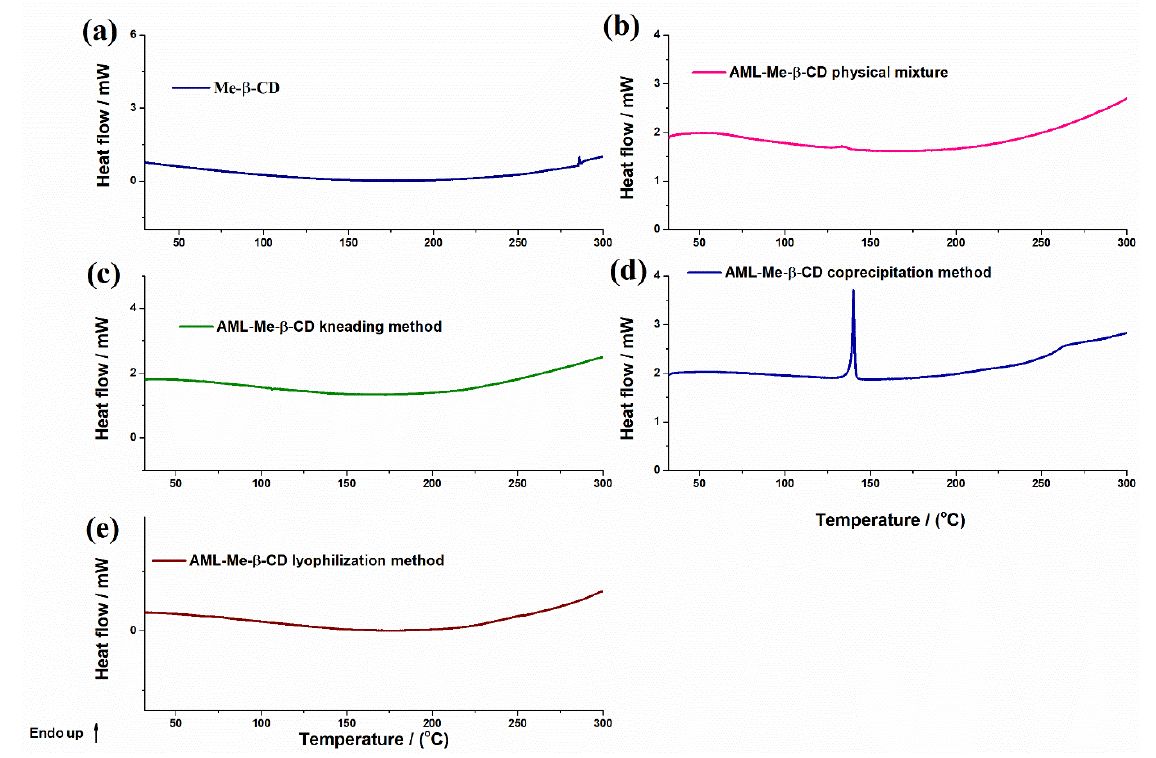
Figure 8. DSC curves of ( a ) Me- β -CD, ( b ) AML-Me- β -CD physical mixture, ( c ) AML-HP- β -CD kneading method, ( d ) AML-HP- β -CD coprecipitation method, and ( e ) AML-HP- β -CD lyophiliza- tion method. The thermodynamic parameters ( T onset , T max , T end ) and heat of the thermal effects (Δ H ) are summarized in Table 3. Table 3. Thermodynamic parameters for the thermal processing of the studied samples obtained from DSC measurements.